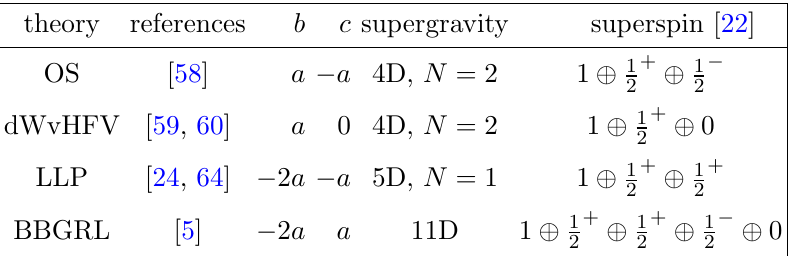
Table 7 . Gravitino multiplets. The generic spinor super(cid:12)eld contains superspins 1 (cid:8) 1 2+ (cid:8) 1 2+ (cid:8) (cid:0) (cid:8) 1 (cid:0) (cid:8) 0. At special points in the parameter space of gravitino Lagrangians L 1 2 2 superspin content is reduced. The two 4D, N = 2 entries correspond to distinct o(cid:11)-shell 4D, N = 1 embeddings